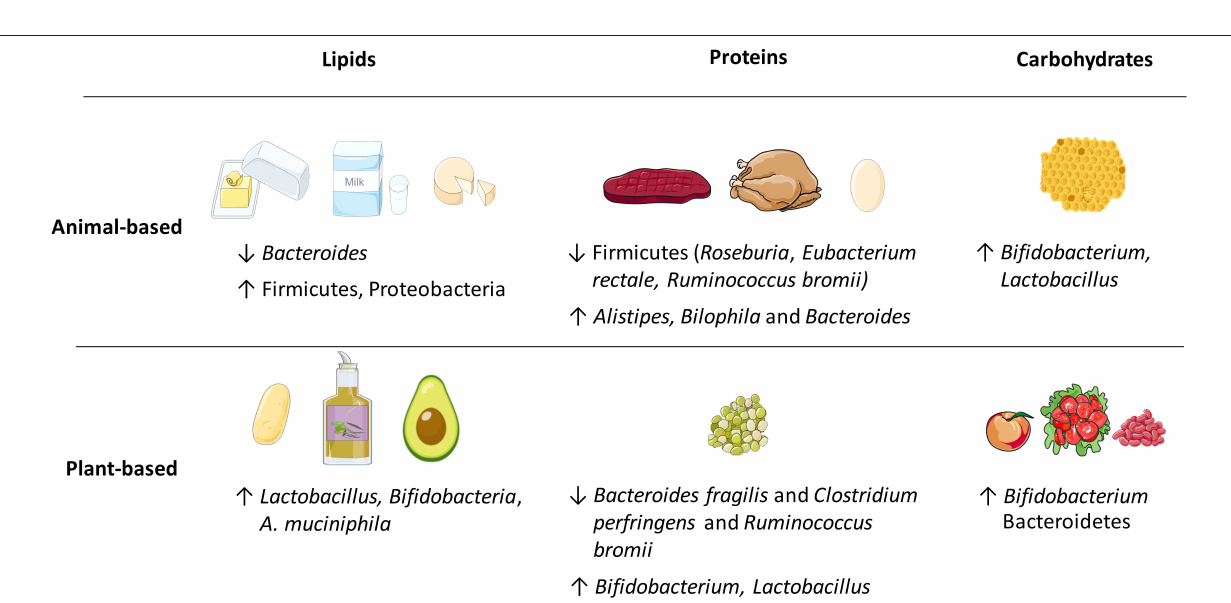
Frontiers in Immunology | www.frontiersin.org